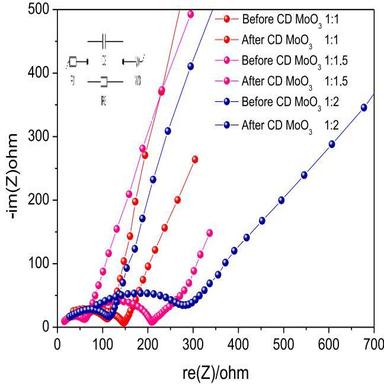
Nyquist plots of MoO3 nanoparticles of different fuel ratio before and after charge–discharge.